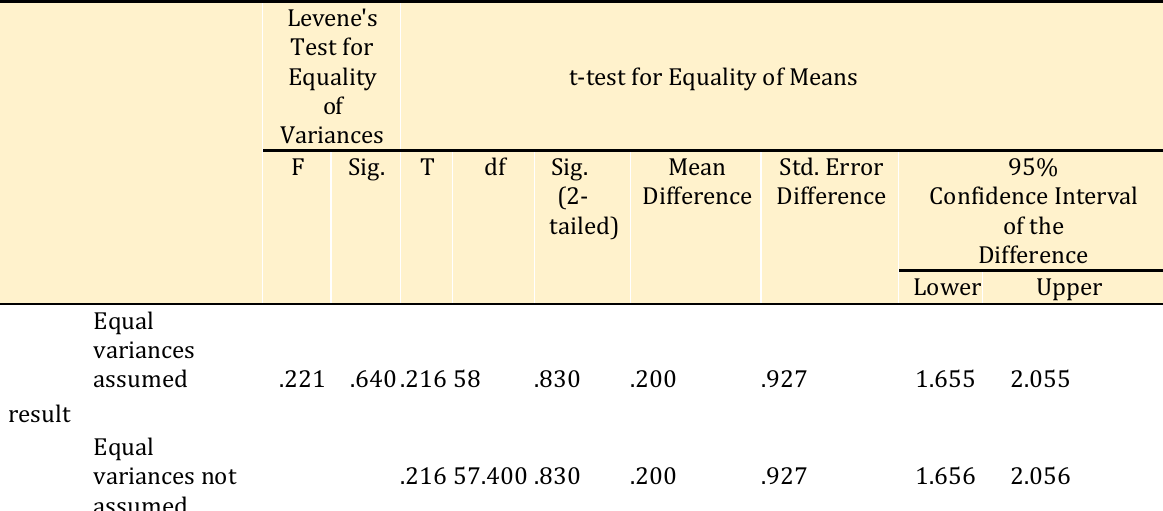
Table 11. The t-test of Posttest for both